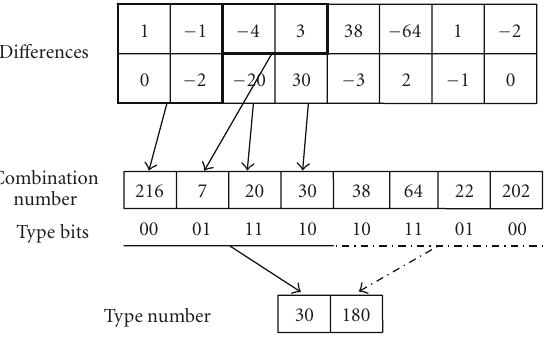
Figure 2: An illustration of the preprocessing